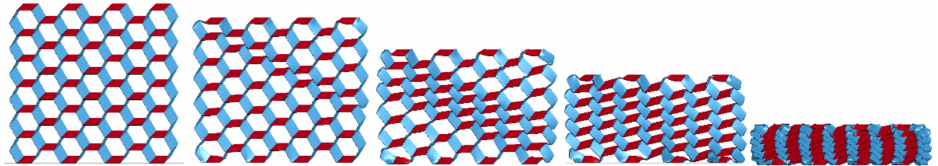
Figure 6. In-plane crushing deformation of origami honeycomb along the y -coordinate. The deformation process of the origami honeycomb under the compression load along the x-coordinate is illustrated in Figure 7. Similar to the y -coordinate, in the x - coordinate crushing process, the origami honeycomb structure also exhibits a layered crushing deformation pattern. However, the origami honeycombs with different folding parameters produce different deformation patterns, namely, symmetrical deformation pattern (Figure 7a), one-sided deformation pattern (Figure 7b), and compound deformation pattern (Figure